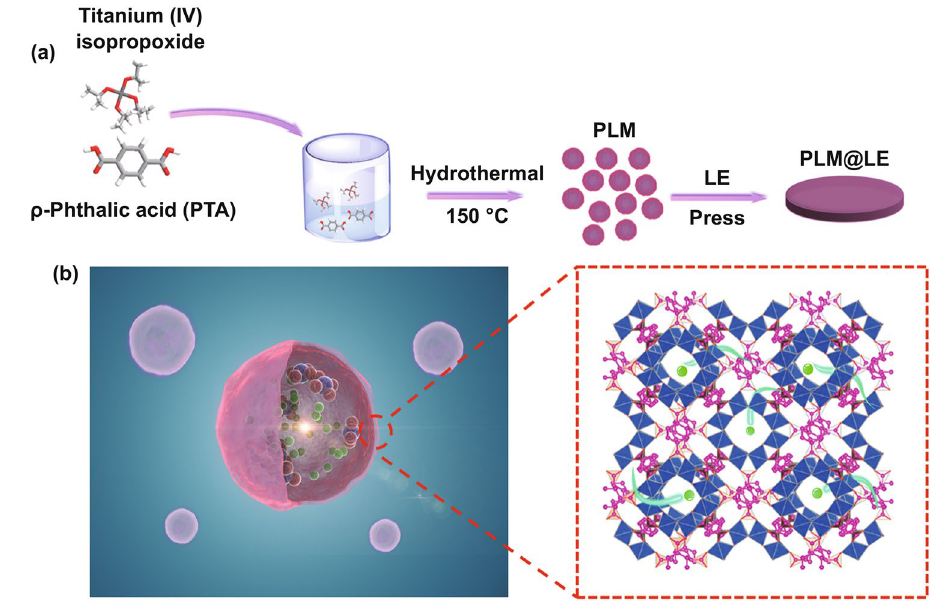
Fig. 1 a Synthetic strategy of PLM@LE. b Top view morphology and crystal structure of PLM (green ball represents sodium ion, and the blue red ball represents other ions or